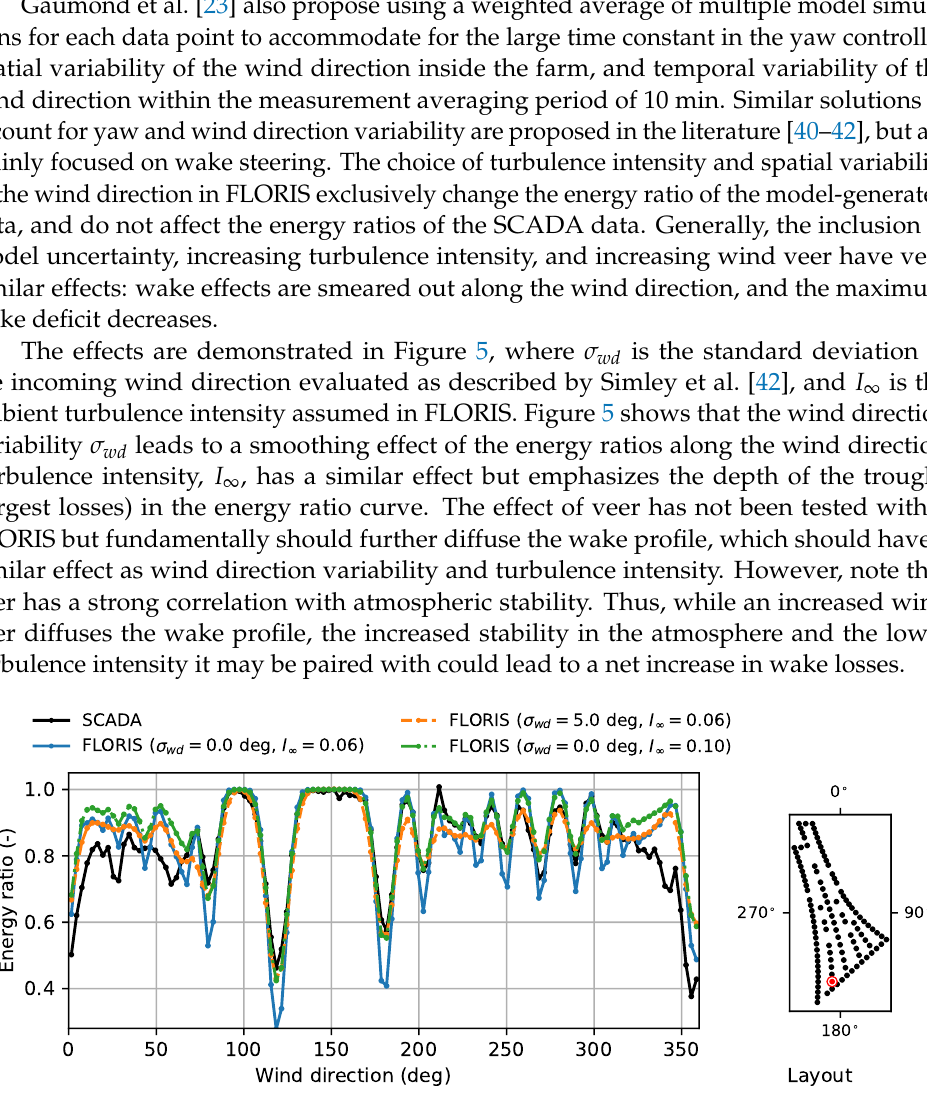
Figure 5. The effect of different atmospheric turbulence intensities and inflow wind direction standard deviations on the energy ratio of test Turbine 32 in the Anholt wind farm. The choice of atmospheric turbulence intensity and inflow wind direction variability in the FLORIS model exclusively change the energy ratios of the model-generated data. The layout schematic on the right shows the location of Turbine 32 in the wind